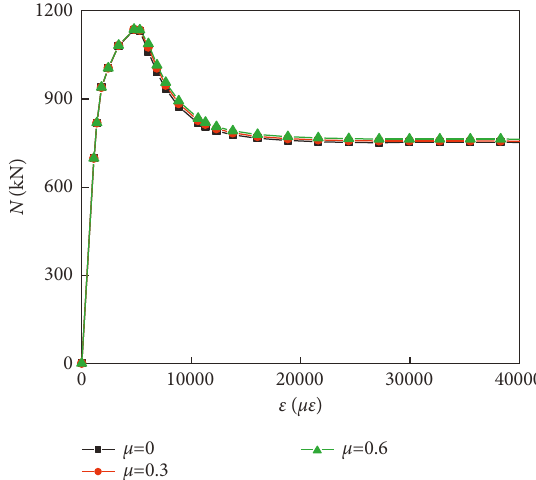
Figure 9: N - ε relationship curve between bond strength and ul- timate bearing capacity.